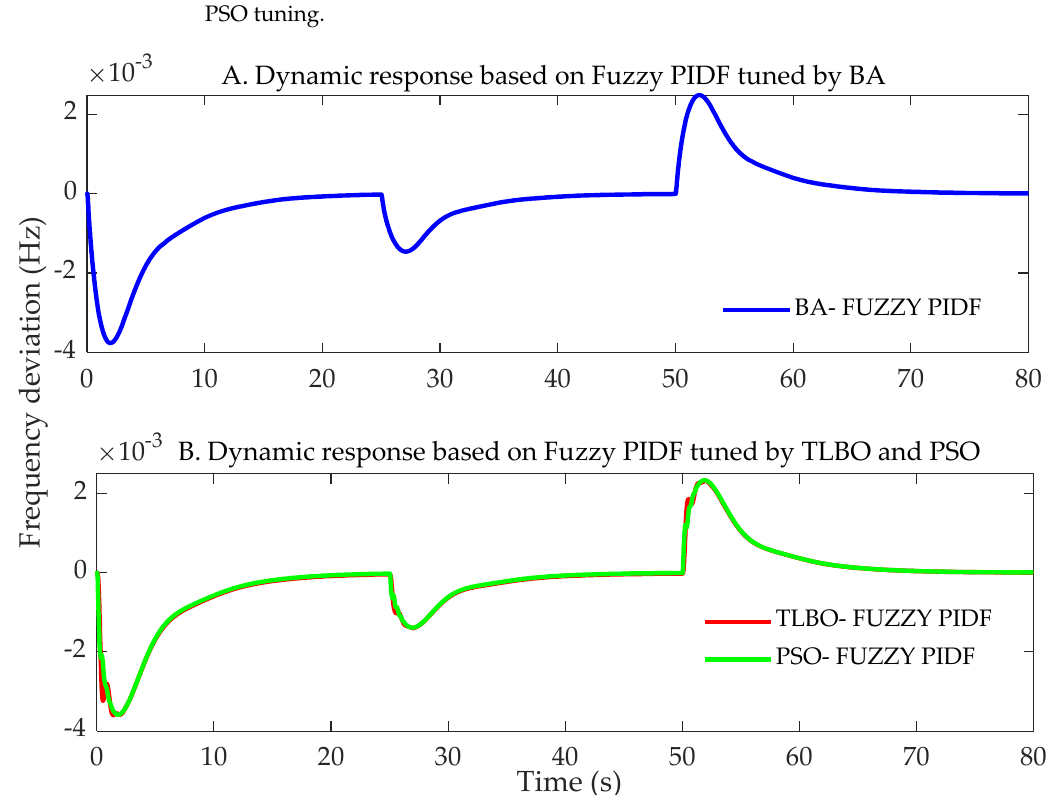
Figure 13. Frequency deviation in area one: ( A ) based on BA tuning and ( B ) based on TLBO and PSO tuning.